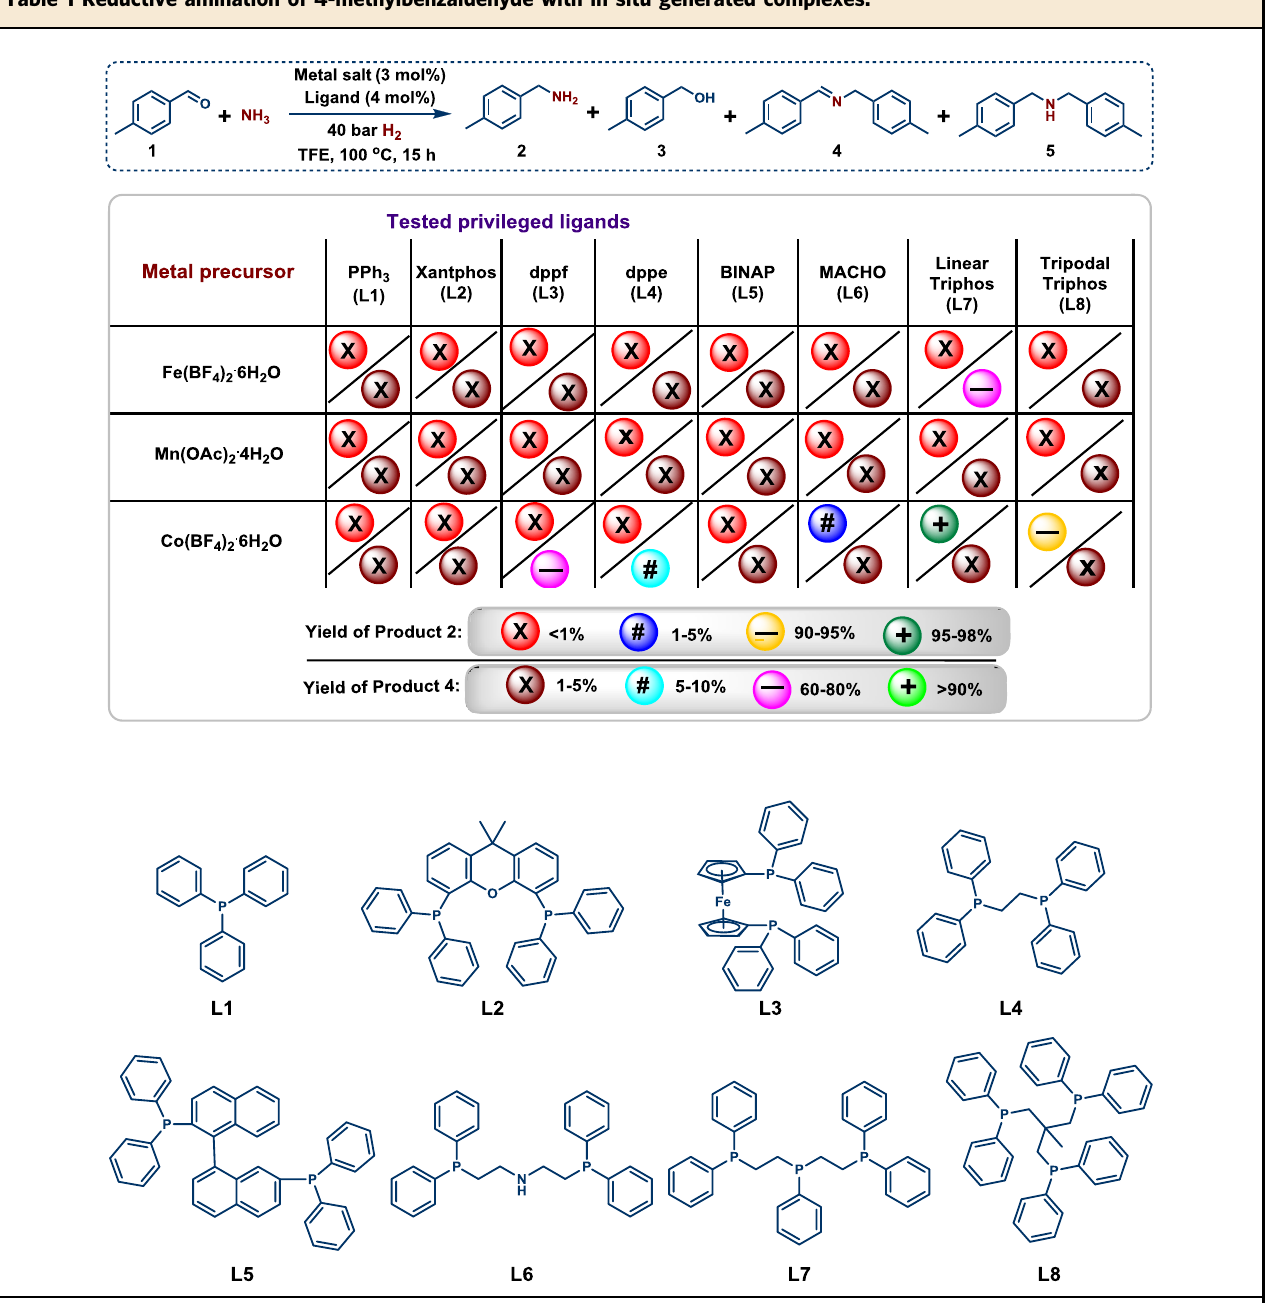
Table 1 Reductive amination of 4-methylbenzaldehyde with in situ generated